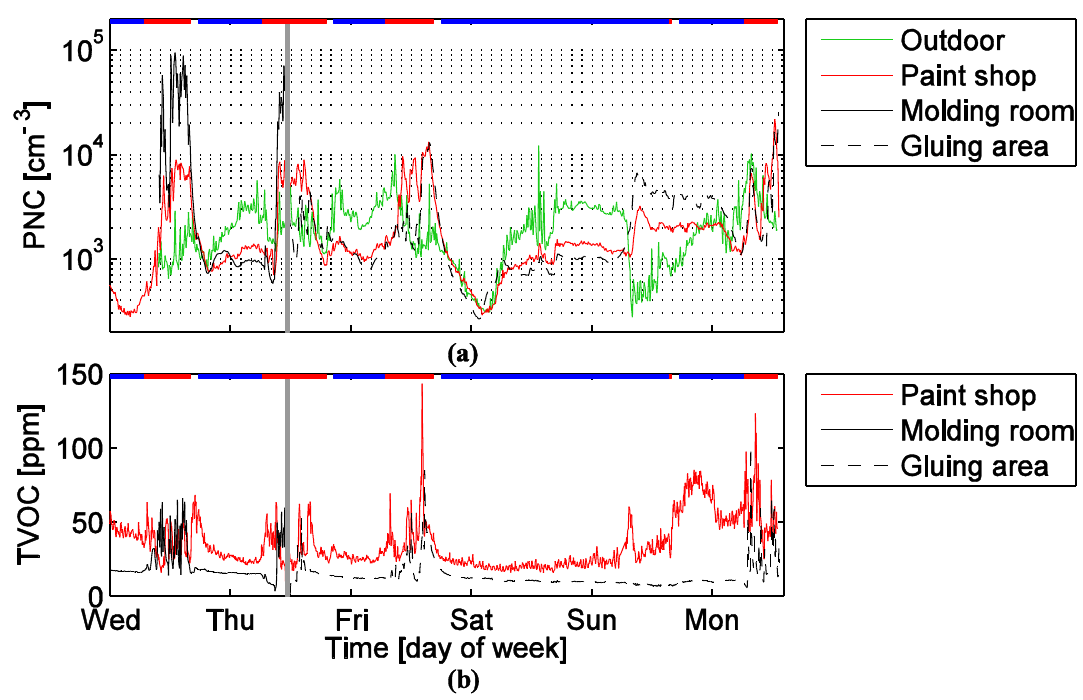
Figure 3. ( a ) Particle number concentrations at 10 minute resolution. ( b ) TVOC concentrations at five minute resolution. The horizontal red lines show the working hours and the horizontal blue lines show non-working hours. The vertical gray line shows when the instruments were moved from the molding room to gluing